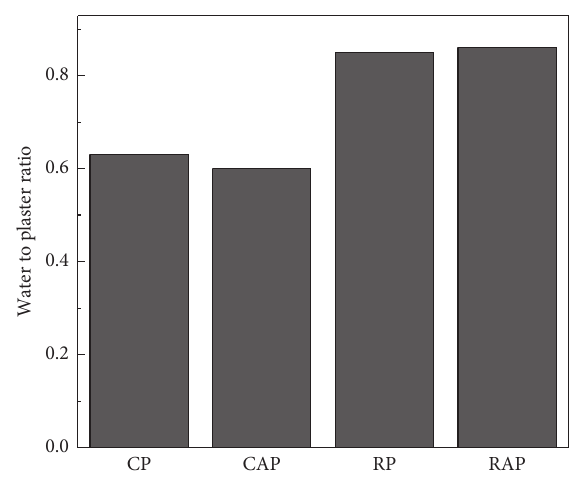
Figure 3: Results of water/plaster